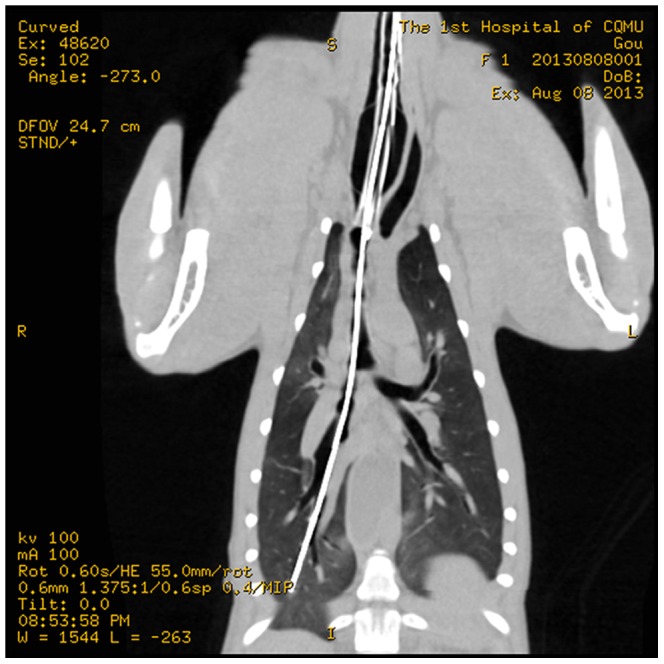
The tip of the micro-imaging fiber extending to the peripheral bronchioles in a canine.